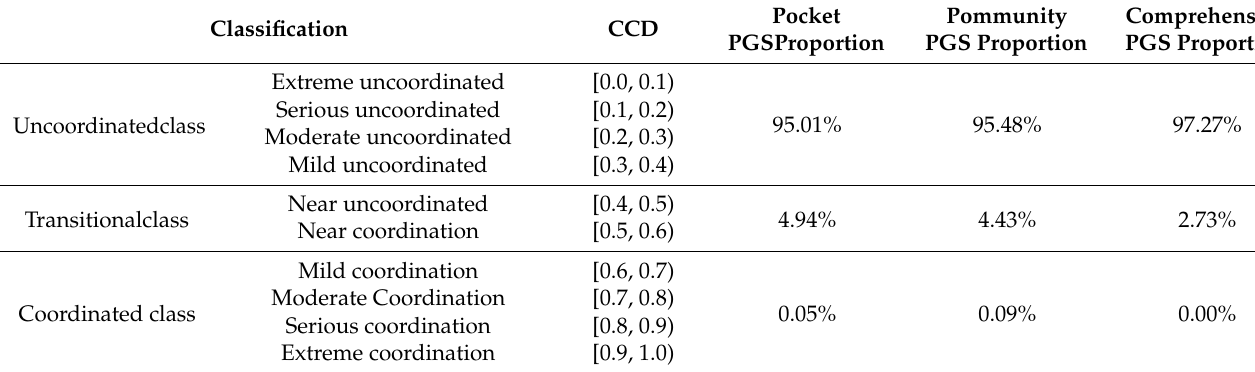
Table 8. Classification and proportion of PGS-SED coupling coordination degree (CCD).